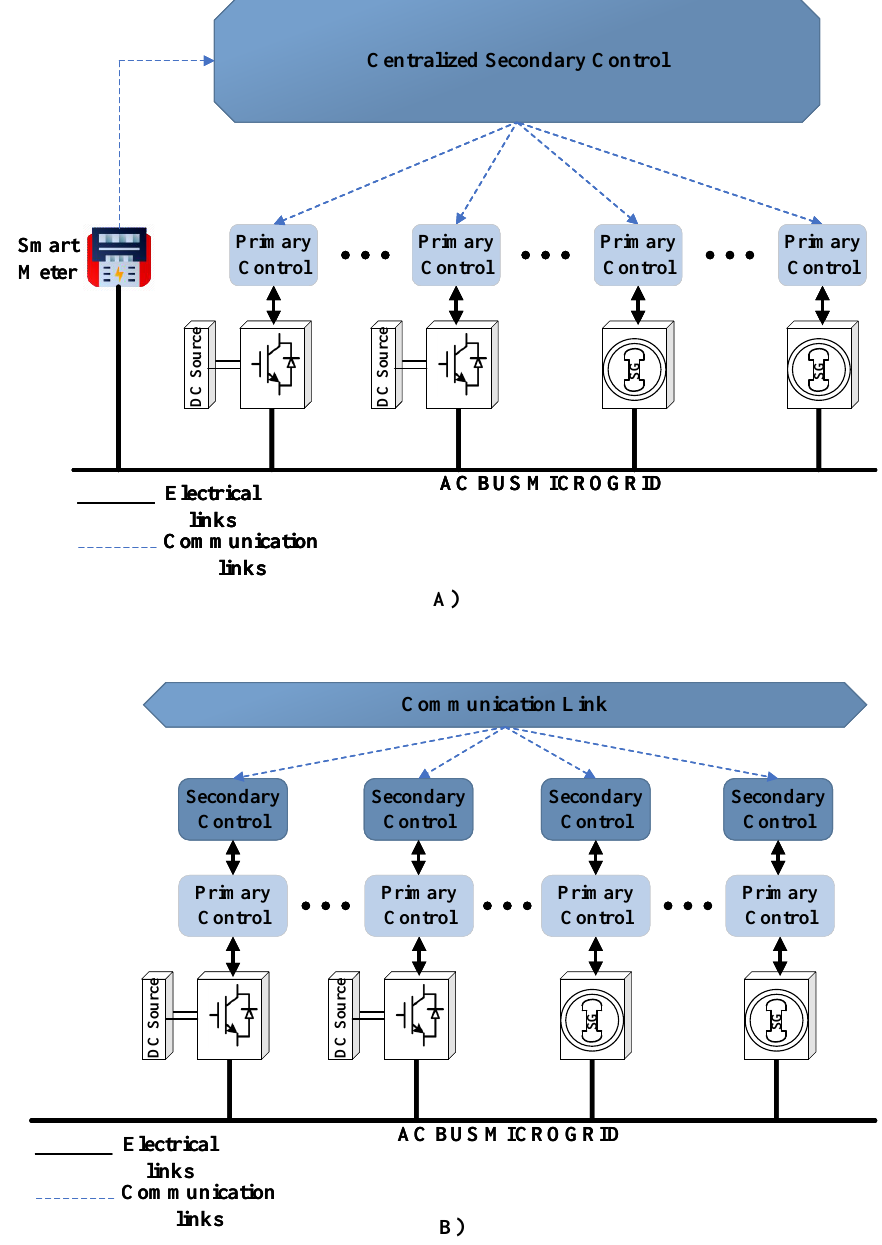
Figure 1. Microgrid control architecture with: ( A ) centralized secondary control; ( B ) decentralized secondary